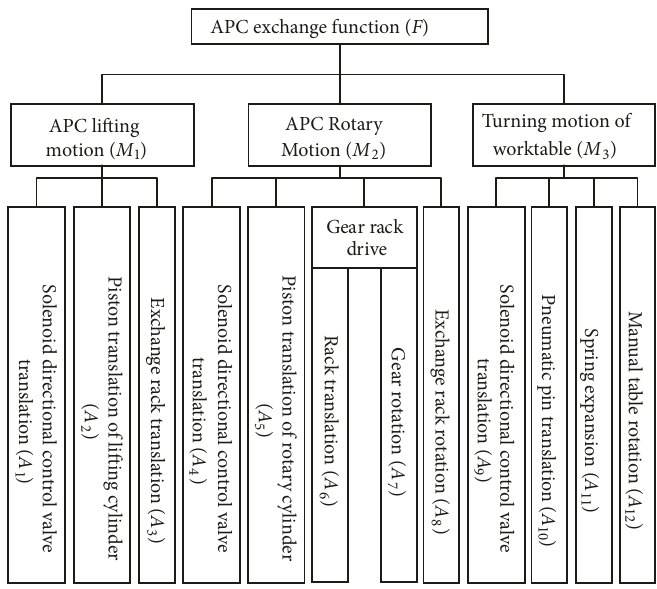
Figure 5: “FMA” decomposition tree for